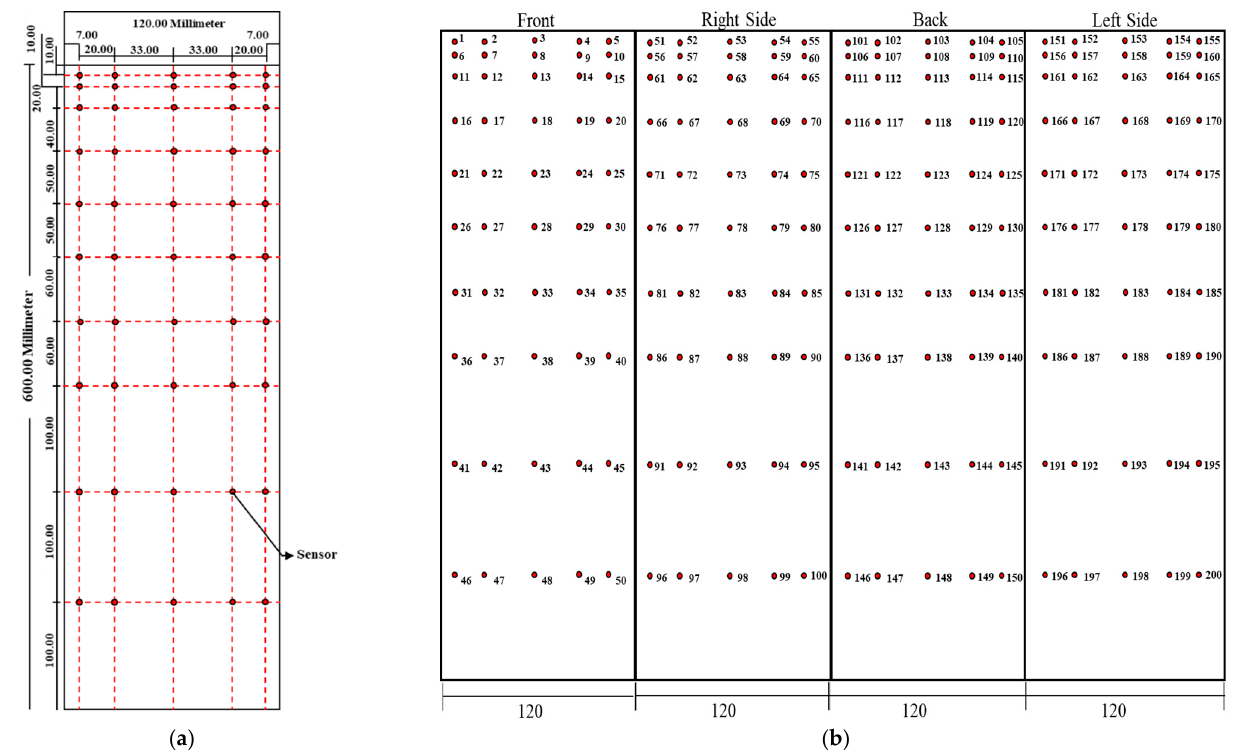
Figure 3. Pressure tap locations ( a ). Relative locations of pressure taps on the proposed building model; ( b ) pressure tap locations on all four sides of the building.